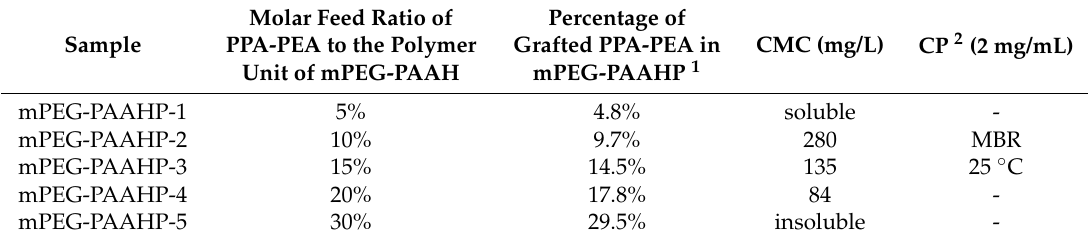
Table 1. Characterizations of mPEG-PAAHPs.